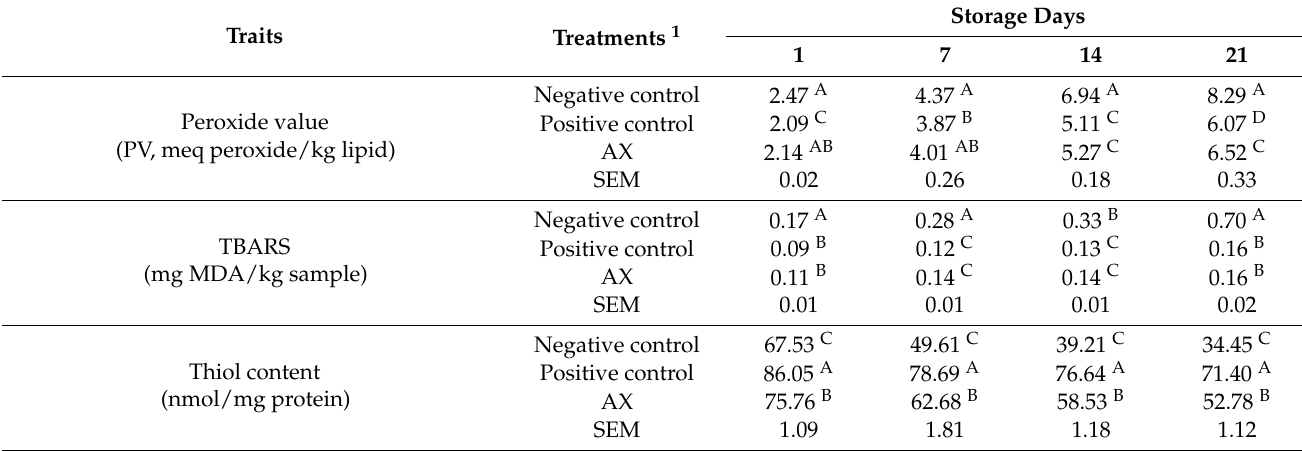
Table 1. Lipid and protein oxidation evaluation during cold storage of emulsified sausages with different antioxidants. Storage Days Traits Treatments 1 1 21 Negative Peroxide value (PV, meq peroxide/kg lipid)